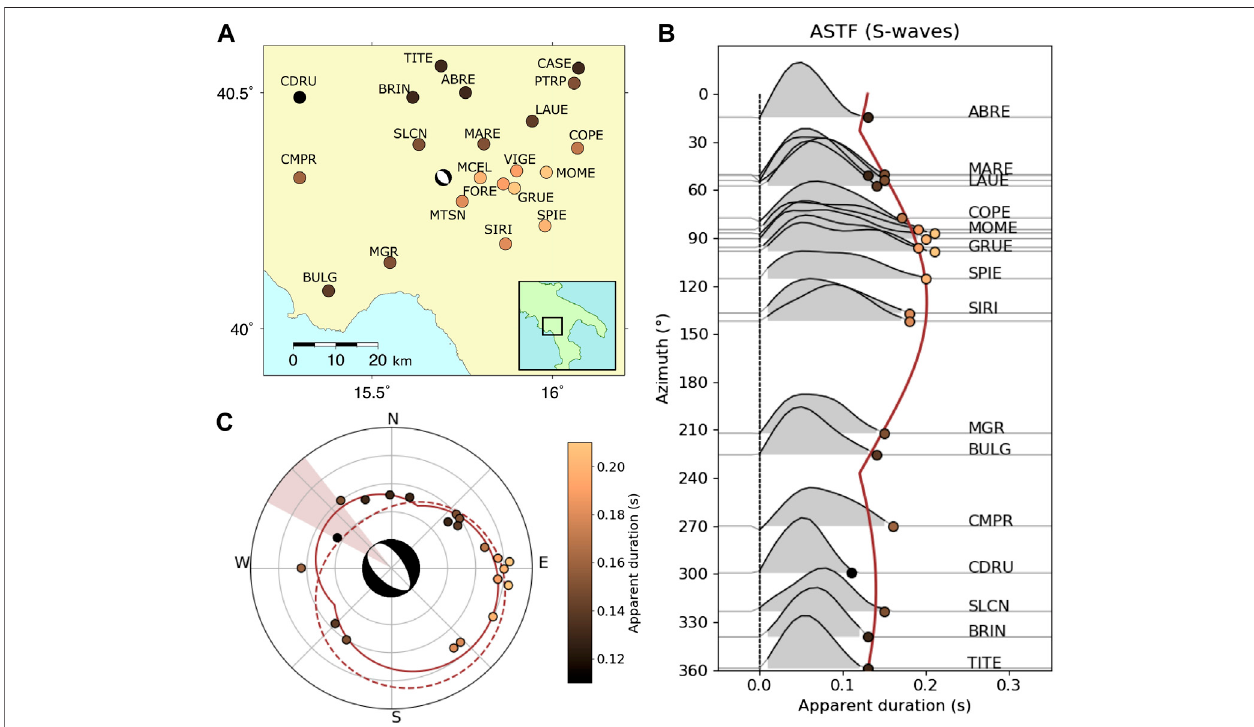
FIGURE 4 | Directivity analysis from the Apparent Source Time Functions (ASTFs) for the 2017 Mw 4 Montesano earthquake, Southern Italy. (A) Map of near- regionalseismicstations used (circles)showingtheapparent durations(colorbar inc)andthemoment tensormechanismfortheMontesanoearthquake. (B) ASTFsare plotted according to station azimuth showing the apparent duration (circles) and moment rate (grey area) for each seismic station (see labels in traces) and the resulting asymmetric bilateral rupture model (solid line). (C) Apparent durations (circles) identi fi ed in (B) along with the synthetic predictions for the resulting asymmetric bilateral rupture model (solid line), represented in a polar plot; predicted rupture directivity and their uncertainties (brown area) are also shown together with the best solution from the moment tensor analysis. Dashed line indicates the solution applying a unilateral rupture model.